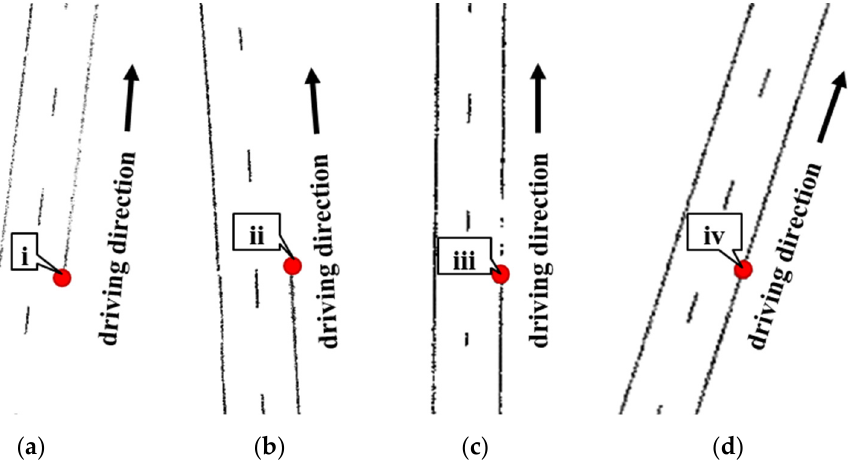
Figure 7. US-52 and 41 northbound LiDAR point clouds (colored by intensity): ( a ) mile marker: 33.84; ( b ) mile marker: 45.64; ( c ) mile marker: 48.22; ( d ) mile marker: 60.76. ( b ) mile marker: 45.64; ( c ) mile marker: 48.22; ( d ) mile marker: